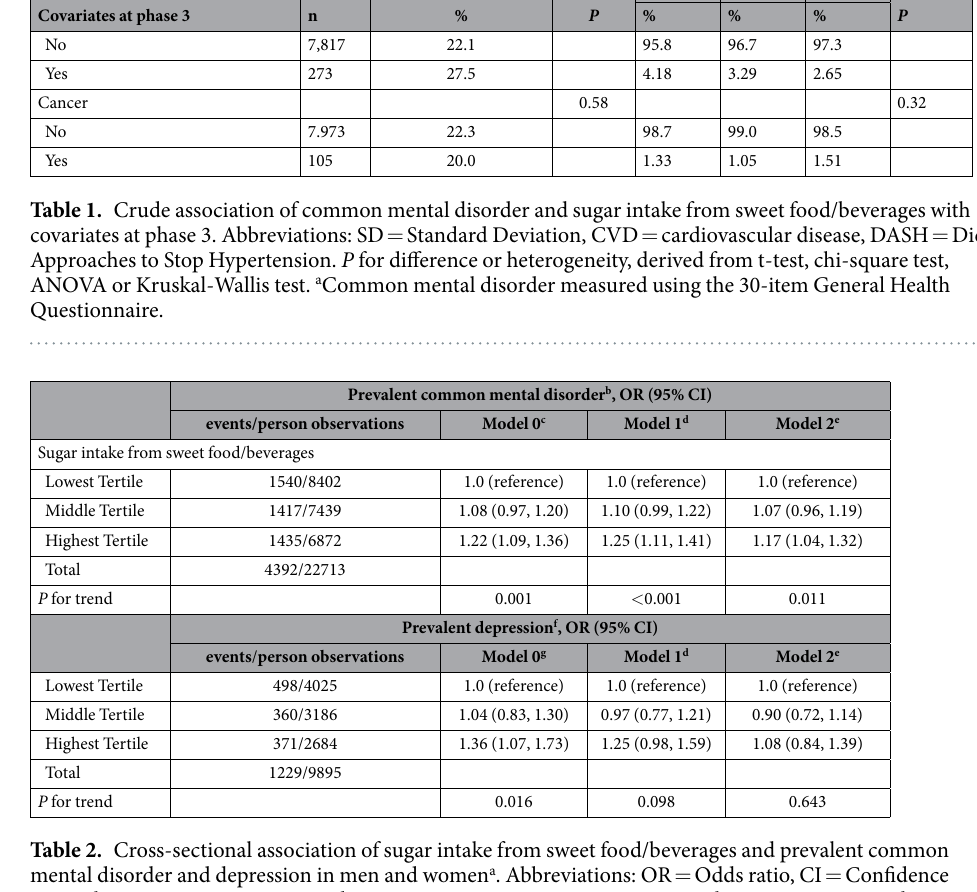
Cross-sectional results. Cross-sectional analyses showed strong positive associations between sugar intake from sweet food/beverages and common mental disorder from the GHQ, as well as CES-D caseness, when adjusted for age, sex and ethnicity (Table 2). There was no evidence for any interaction with sex ( P = 0.8 for GHQ and P = 0.7 for CES-D). The association with CMD was robust whereas for depression it was removed on adjust- ment for socio-demographic factors, health behaviours and diet-related factors (Table 2). Further adjustments for central obesity and physical health (not shown), exclusion of 709 person-observations (377 in CES-D analysis) with reported doctor diagnosis of depression and person-observations with extreme values of sugar intake at baseline did not change the results. Prospective results. Prospective analyses regarding incident CMD were stratified by sex, since interactions with sex were observed in the 5 years later model (LR test for sex interaction: GHQ 2 years later, P = 0.26: GHQ 5 years later, P = 0.05). In women, no associations were found for incident CMD with tertiles of sugar intake from sweet food/beverages (after 2 years, highest vs. lowest tertile OR: 0.98; 95% CI 0.72, 1.34; P for tertile trend = 0.90; after 5 years, highest vs. lowest tertile OR: 0.94; 95% CI 0.74, 1.19; P for tertile trend = 0.59). In men, after adjustment for age and ethnicity, sugar intake was associated with incident CMD 2 and 5 years later (Table 3). In further models, the association with 2-year incidence attenuated but the association with 5-year incidence remained (Table 3) and further adjustments for BMI, central obesity and physical health (not shown) resulted in an OR for highest vs. lowest tertile of: 1.23, 95% CI: 1.02, 1.48, P for trend = 0.03. Excluding participants who reported a doctor diagnosis of depression at each baseline strengthened the association (Model 4 for CMD after 5 years, Person observations = 10944; highest vs. lowest tertile OR; 1.25; 95% CI 1.03, 1.50; P for trend = 0.02,